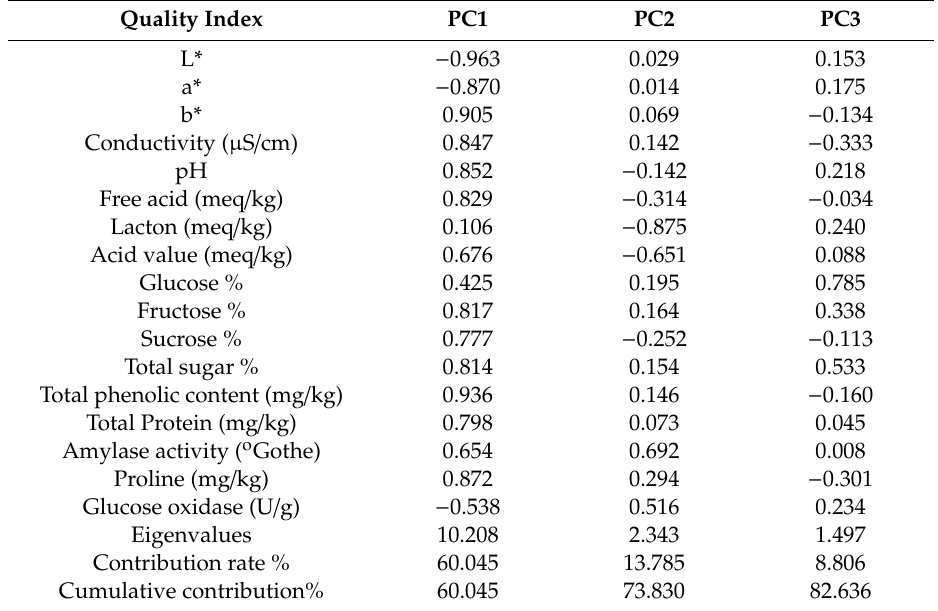
Table 3. Variance contribution rate and composition load matrix. PC, principal